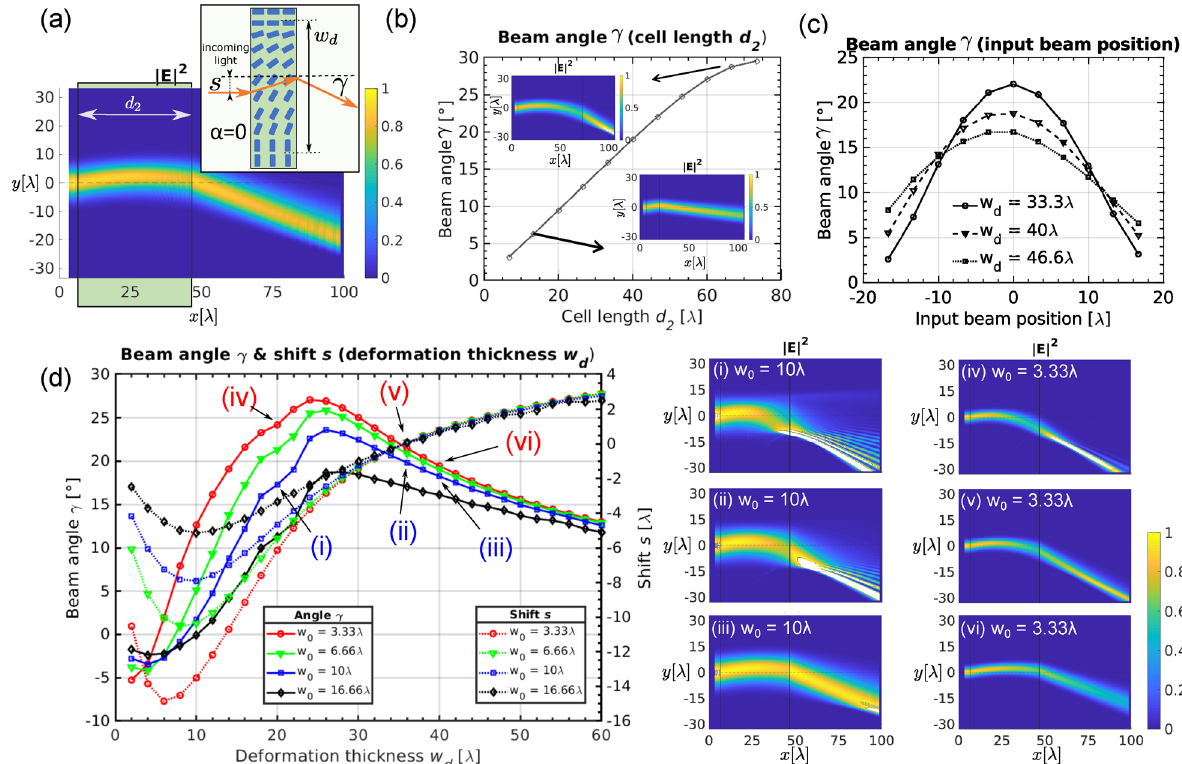
Figure 4. Deflecting the beam. ( a ) The incoming Gaussian beam, which is normal to the building block, is deflected at an angle γ ∼ 20 ◦ and shifted upwards. Inset shows schematic representation of the building block with the deformation thickness w d which shifts the incoming beams for the distance s and deflects it to an angle 2 of γ as shown with simulated normalized electric field intensity | E | . The beam deflection angle γ can be tuned by changing ( b ) the building block length d 2 , ( c ) position of the input beam or the ( d ) deformation thickness w d . ( c ) Dependence of the beam angle γ on the position of the incoming beam. Both ( b ) and ( c ) are calculated for w 0 = 6.66 (cid:31) and w d = 40 (cid:31) / d 2 = 40 (cid:31) , respectively. ( d ) Changing the deformation thickness w d with respect to beam waist w 0 greatly affects the shift s and deflection angle γ and can be tuned with external electric fields. Length of the building block was fixed to d 2 = 40 (cid:31)